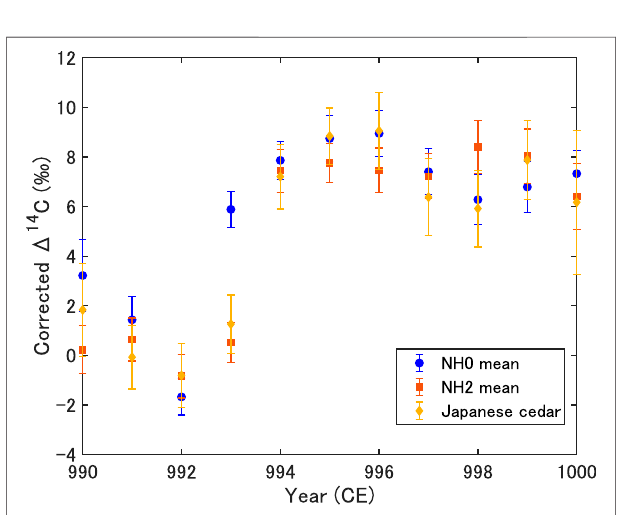
FIGURE 5 | Comparison between the weighted average of NH0 and NH2 series (Japanese cedar series is also shown). The average of 990 – 992 CE of each series is adjusted to zero on the vertical